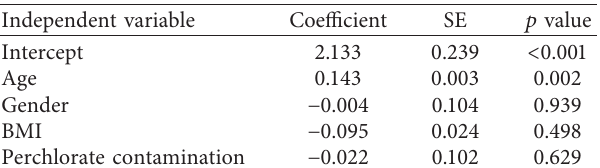
Table 5: Regression analyses of association between perchlorate and